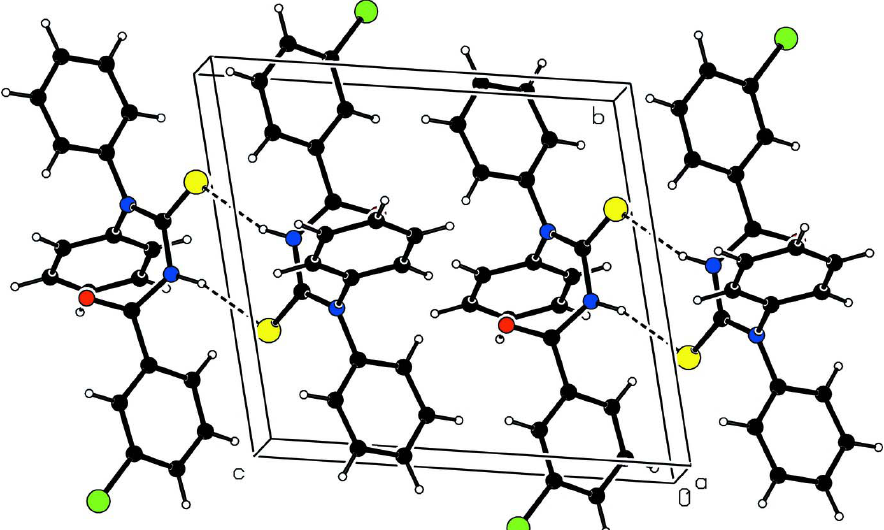
Figure 2 A packing diagram for (I). Hydrogen bonds are shown as dashed